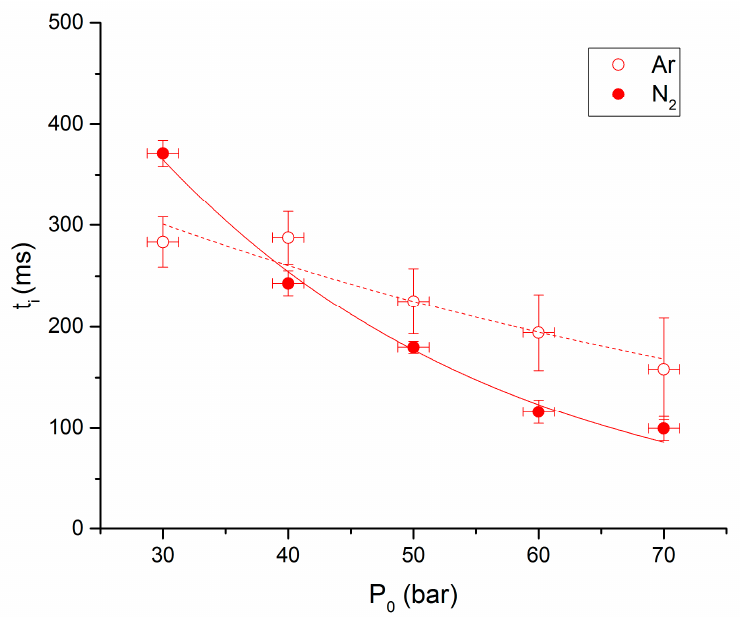
Molecules 2020 , 25 , x FOR PEER REVIEW Figure 11. Propagation rate vs. P0 for the 90-10 propellant under N 2 and Ar. Figure 11. Propagation rate vs. P0 for the 90-10 propellant under N 2 and Ar.